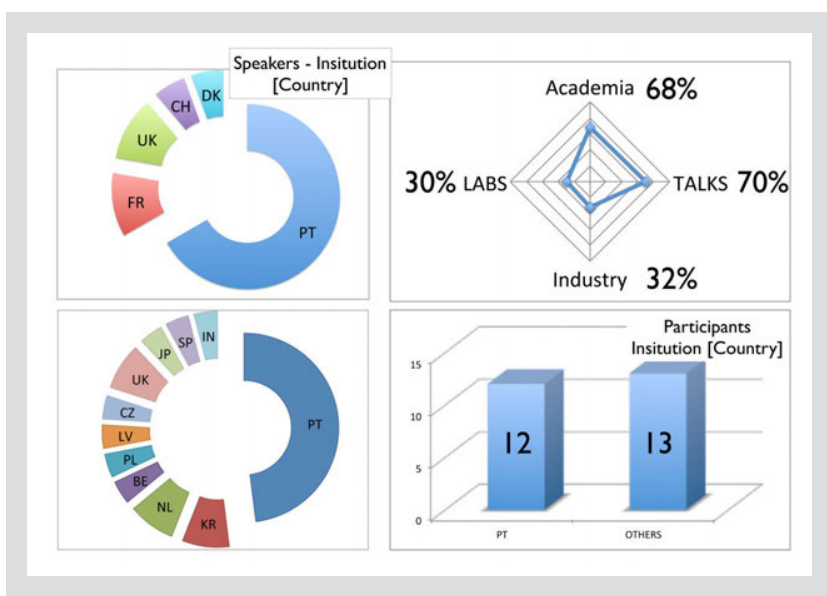
Figure 2: Some statistics about the participants and speakers during the